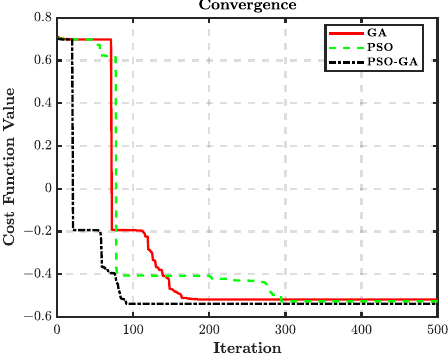
Figure 7. Convergence of the objective function with different optimization algorithms.